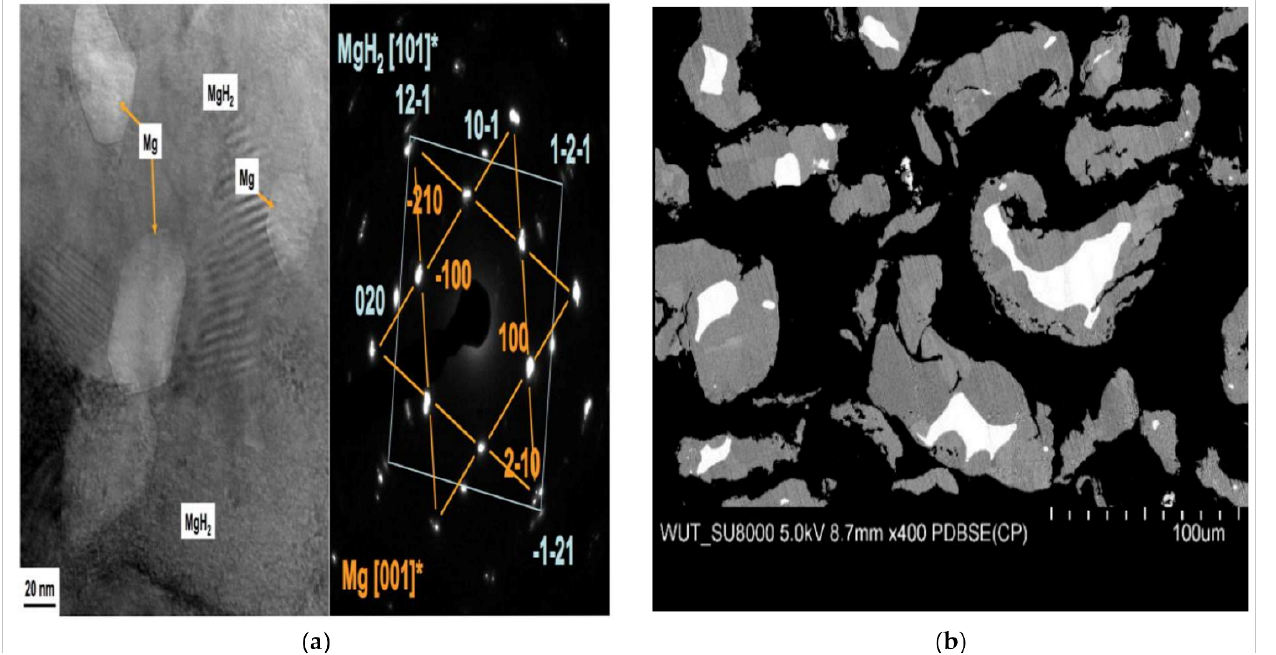
Figure 44. ( a ) A TEM image and selected area electron diffraction patterns from Mg and MgH 2 phases in a nominally fully hydrogenated sample. Reproduced with permission [71]. Copyright 2015, Springer Nature. ( b ) Cross-section of commercially available magnesium hydride particles with visible white magnesium cores. Reproduced with permission [3]. Copyright 2020,